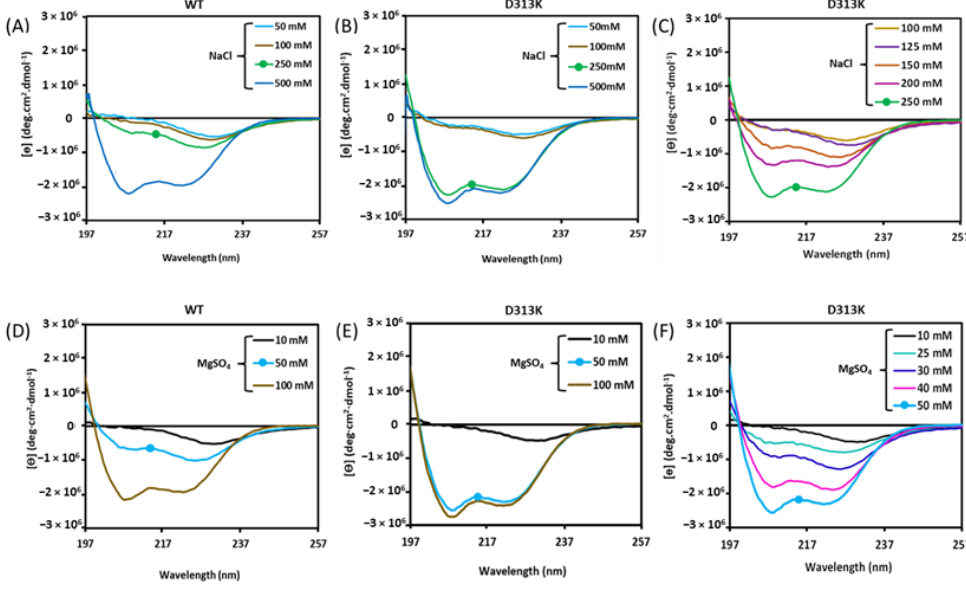
Figure 2. CD spectra of cl-Par-4 as a function of cation concentration for ( A ) WT with Na + [39]; ( B , C ) D313K with Na + ; ( D ) WT with Mg 2+ [39]; and ( E , F ) D313K with Mg 2+ . The intermediate salt concentrations (250 mM NaCl and 50 mM MgSO 4 ) for which the WT and mutant CD spectra differ the most are marked with a dot. All data were acquired at pH 7.0 and 25 ◦